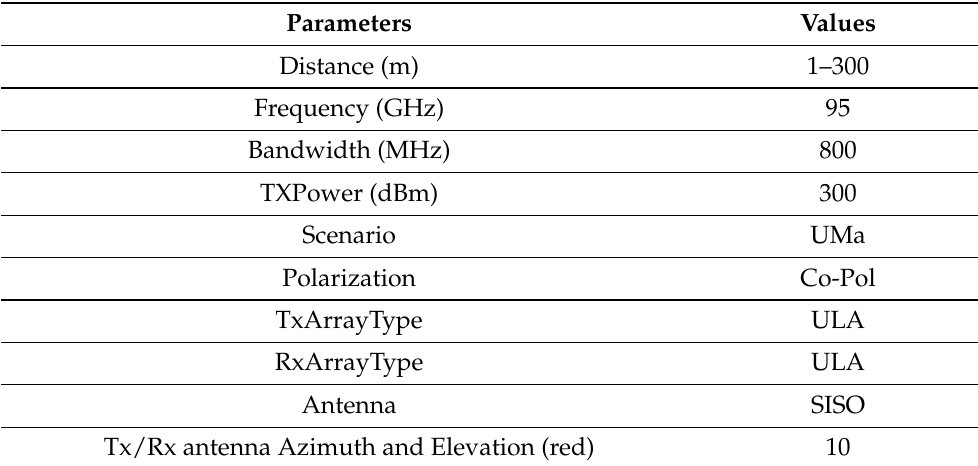
Table 1. Channel measurement parameters.